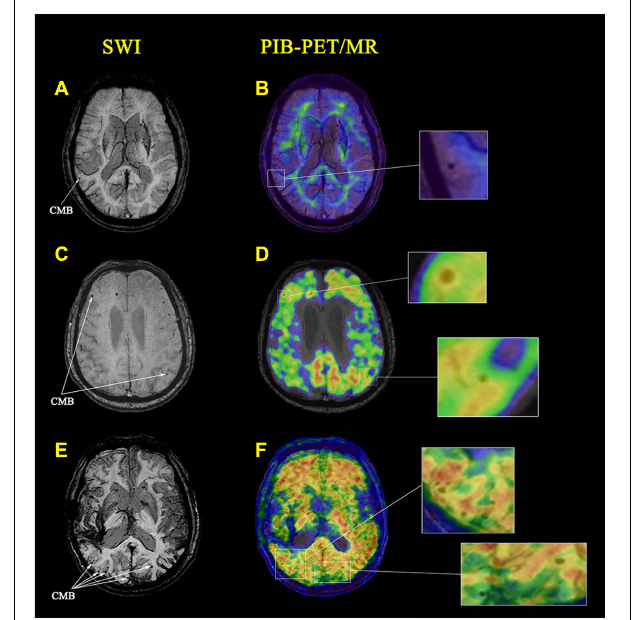
FIGURE 2 | Cerebral microbleeds (CMBs) identified on images from magnetic resonance imaging (MRI) and PIB PET in a representative cognitively normal healthy control subject (NC) and patients with Alzheimer’s disease (AD) and CAA. (A) An axial susceptibility-weighted imaging (SWI) MRI scan from a 70-year-old woman with hypertension. A CMB is present in the right temporal lobe (white arrows). (B) A PIB-PET scan shows no lobar amyloid deposition (amyloid-negative) with only non-specific white matter deposition. (C) An axial SWI MRI scan from a 64-year-old man with long-standing hypertension. CMBs are present in the right frontal and left temporal lobes (white arrows). (D) A PIB-PET scan shows increased amyloid deposition in the right frontal lobe with no amyloid deposition in the left temporal lobe. (E) An axial SWI MRI scan from a 70-year-old woman without hypertension. CMBs are present in the bilateral occipital and temporal lobes (white arrows). (F) A PIB-PET scan shows widespread cortical amyloid